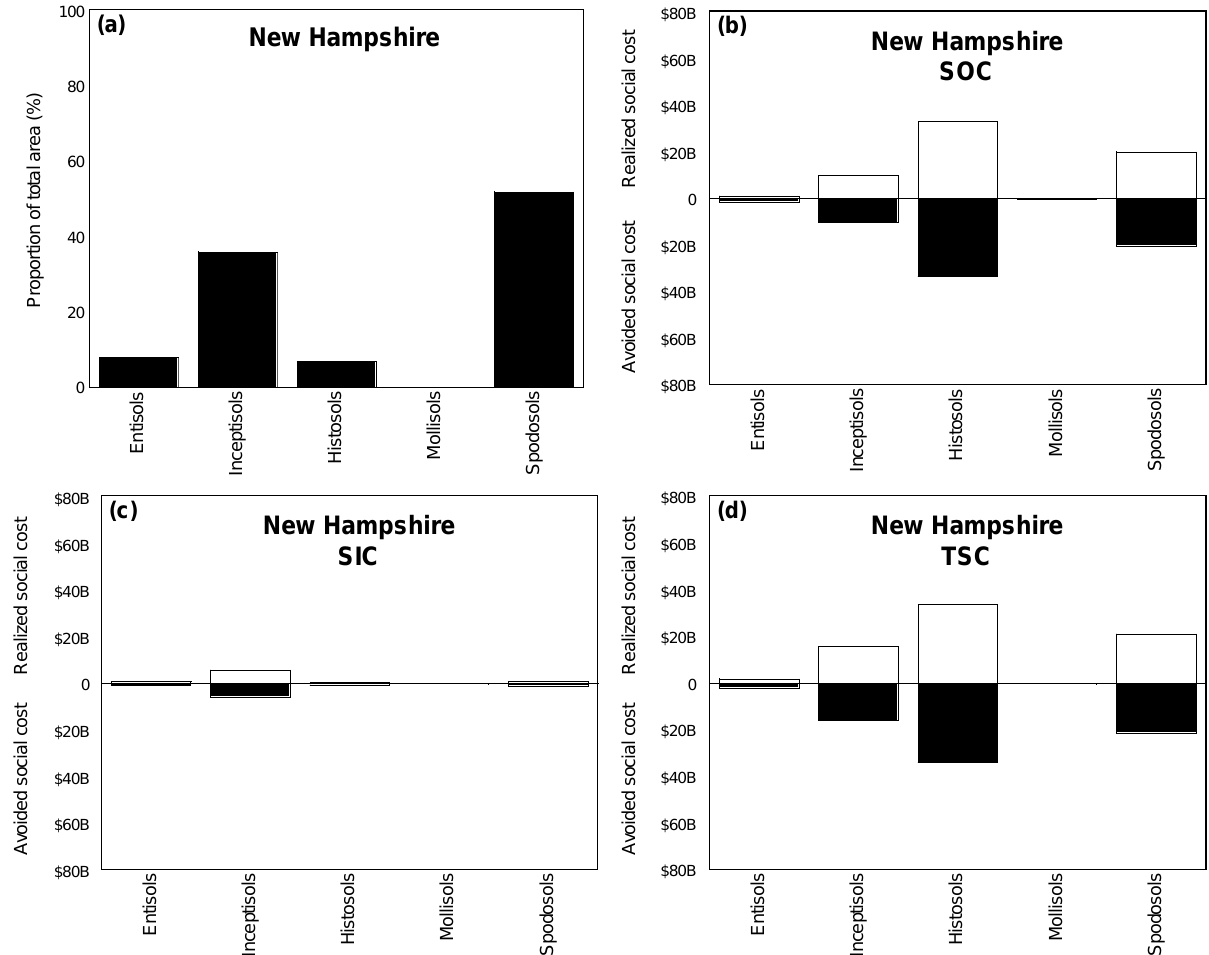
Figure 4. Diagram showing how the “ portfolio-effect ” and “ distribution-effect ” of pedodiversity can vary within the state by soil order: ( a ) pedodiversity by area of soil order; ( b ) monetary value of soil organic carbon (SOC) storage or potential cost if all SOC is released as CO 2 emissions, ( c ) similar value or potential cost associated with soil inorganic carbon (SIC), ( d ) similar value or potential cost associated with total soil carbon (TSC). Monetary valuation is based on soil C in the upper 2-m depth and a social cost of CO 2 emission of $46 (USD) per metric ton of CO 2 [19]. Note: B = billion = 10 9